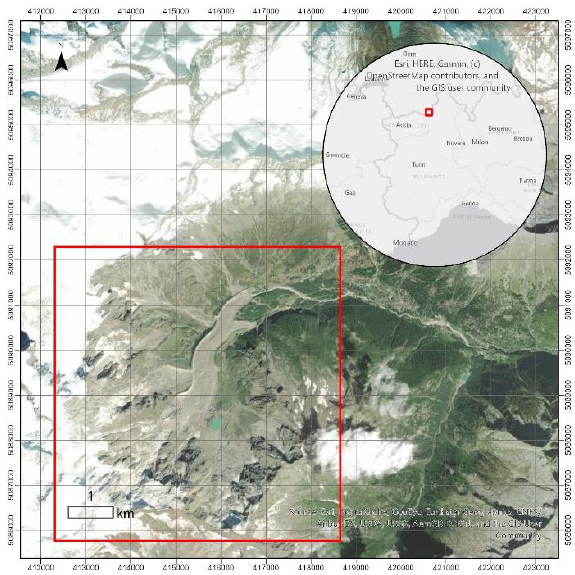
Figure 1. Belvedere glacier: overview map (UTM projection, Zone 32N, Datum ETRF2000)